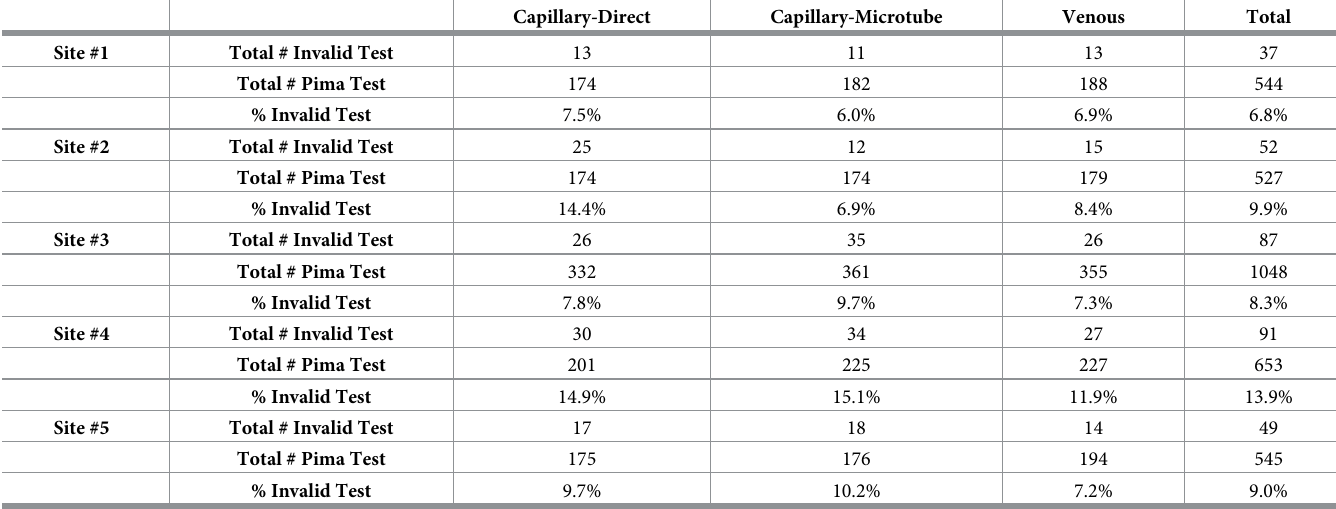
Table 3. Healthcare sites invalid tests per specimen